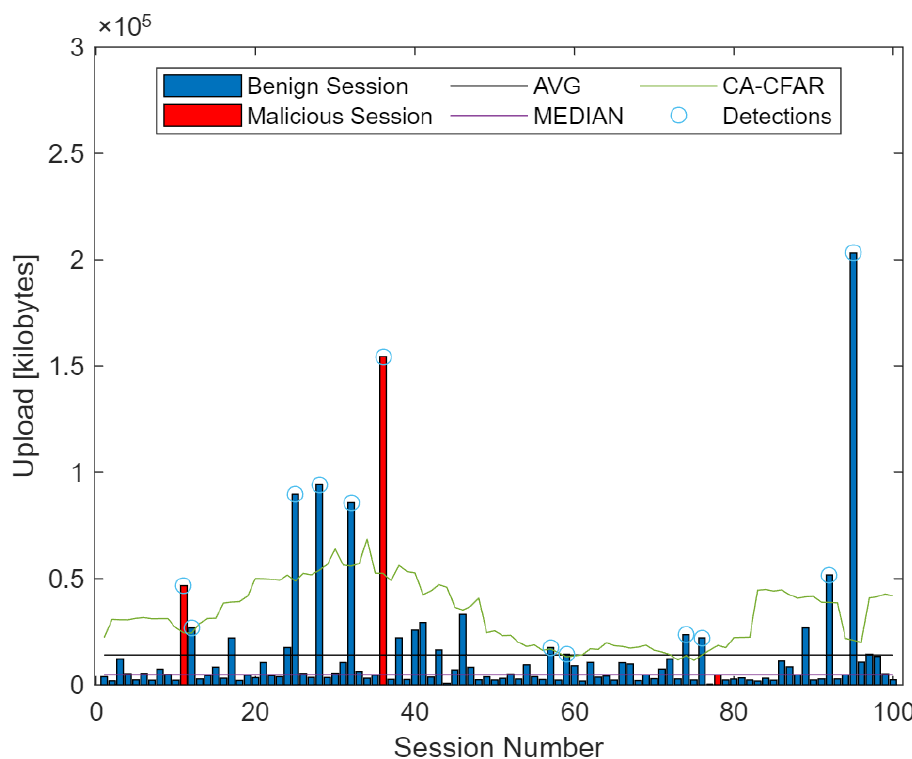
Figure 21. Detection based on the information about upload